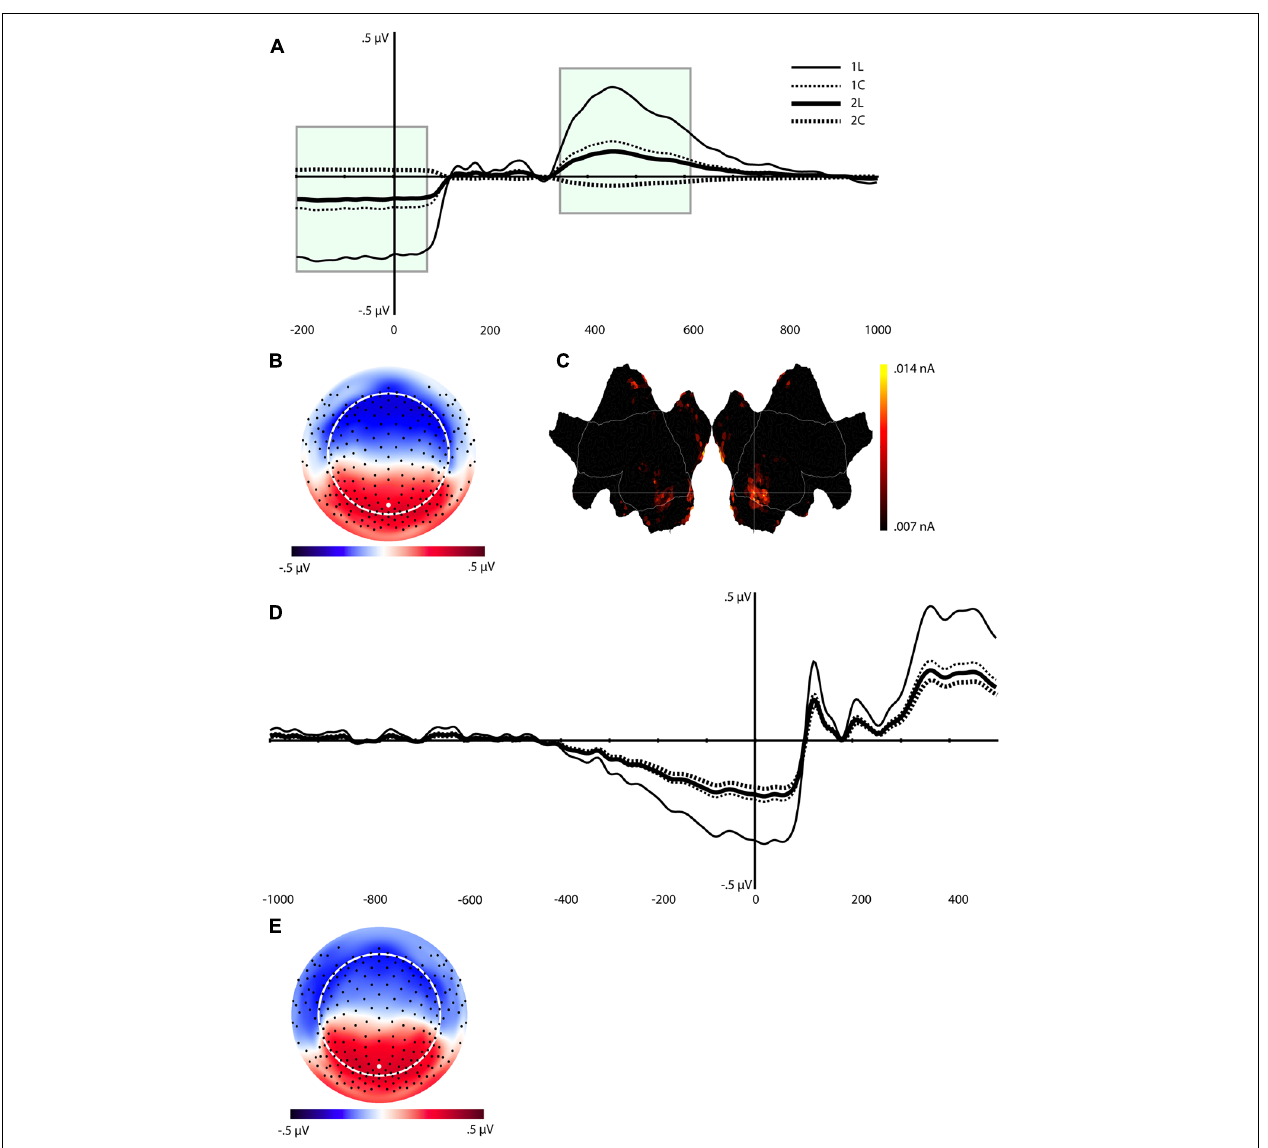
represents the lateral surface (outside of this is the medial wall); the left side is the left hemisphere. Activity was thresholded to show the top 10% of source activity. (D) This component waveform was re-computed with temporospatial analysis using a long prestimulus interval [see Component 1 (C1)]. (E) Topographic map showing voltage distribution, with the same topography as when computed with a shorter baseline. This component also showed a similar pattern of cortical source activity as the C1 in Figure 4C